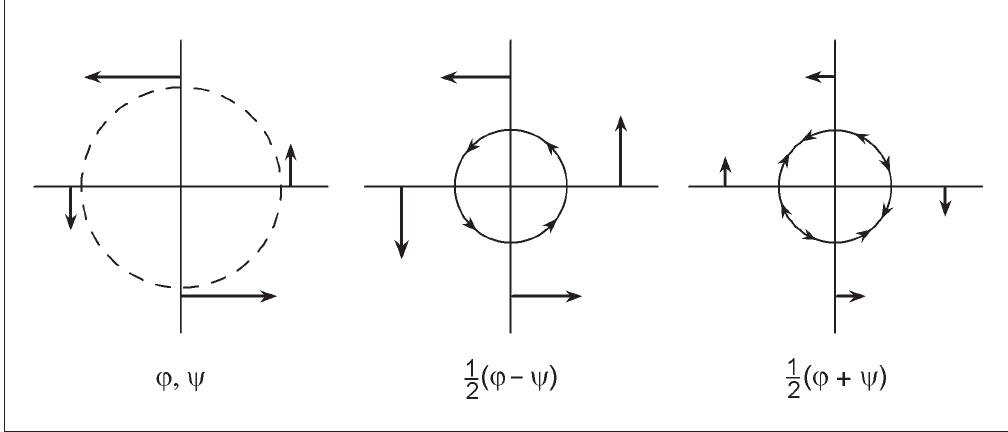
Fig. 7. Scheme presenting the micro-displacement components related to the grain surface (left), the related ro- tation (center) and twist motion